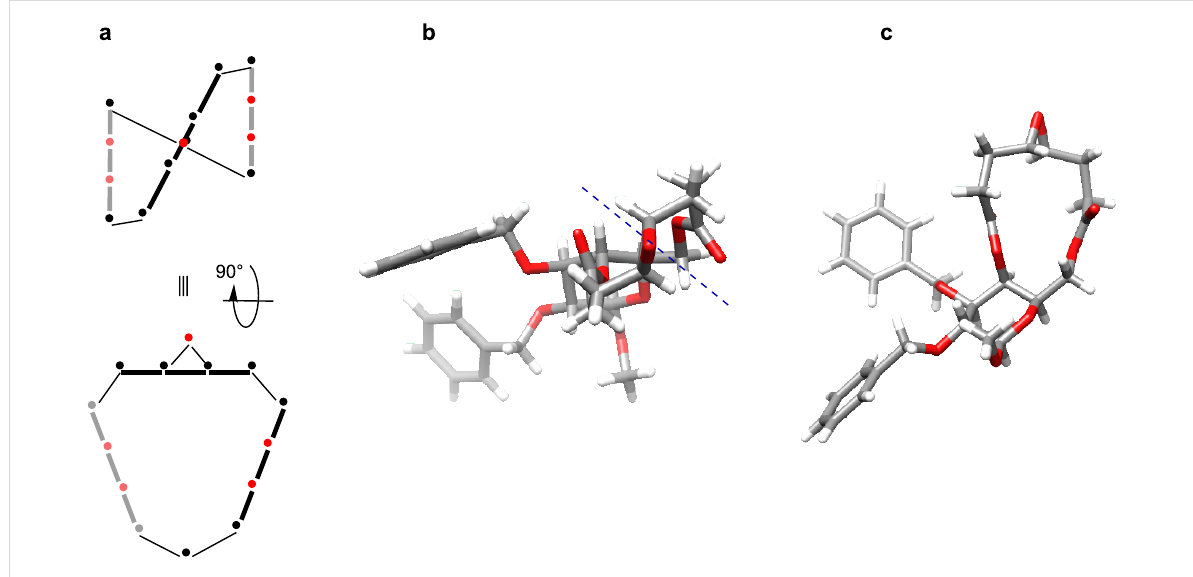
Figure 2: Structure of macrolide 3 ; a) schematic representation of 3 emphasizing four-atom planar units of the [13]-macrodiolide motif; b) and c) the structure of 3 from X-ray data that corresponds to the schematic representation. An axis of chirality associated with the topology of the macrocycle is indicated with a dashed line in b).